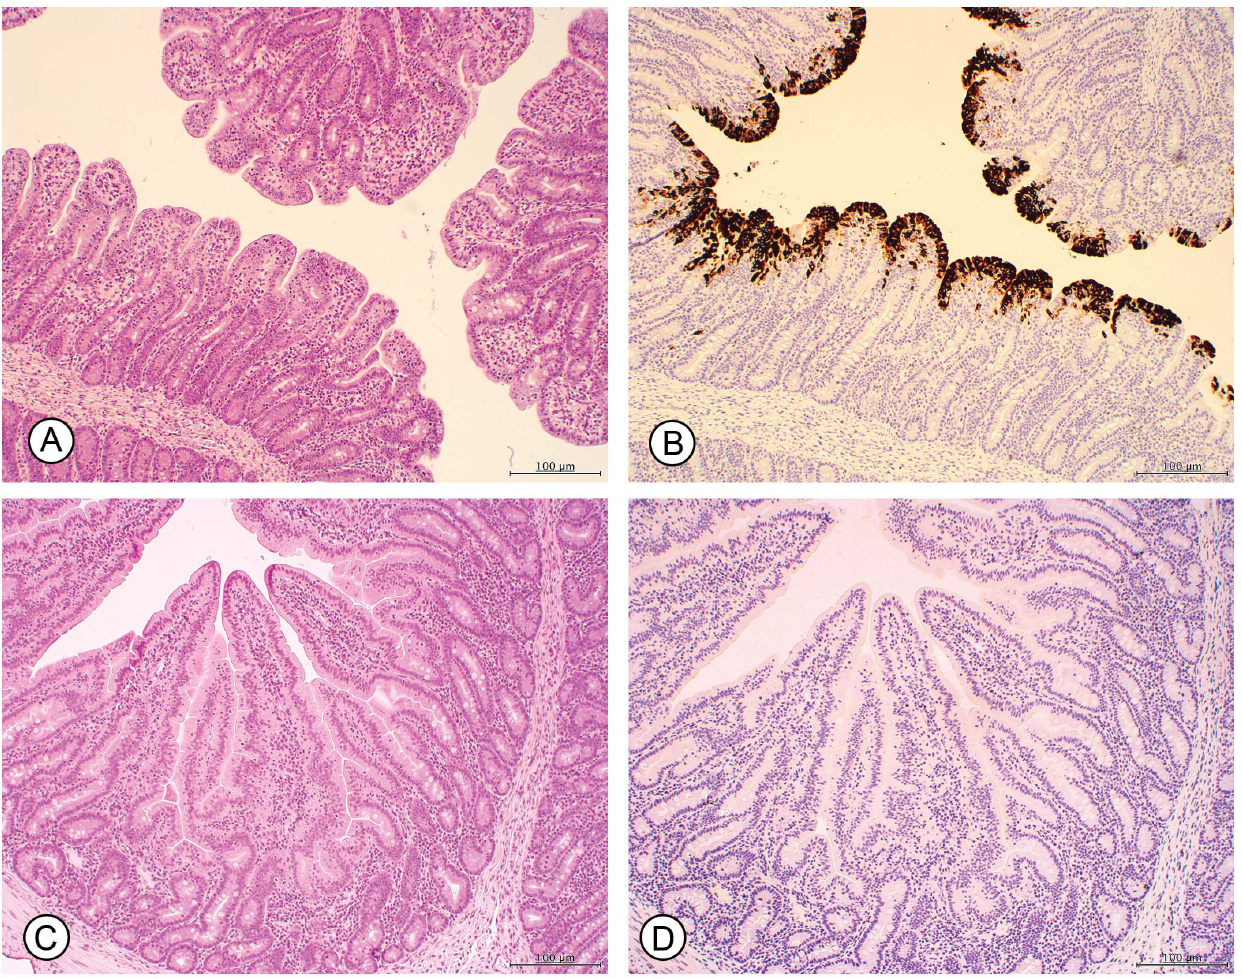
Figure 3. Microscopic lesions in the small intestines at 3 days post PEDV inoculation. ( A ) PEDV-CONTROL. HE. There is severe diffuse atrophy and fusion of villi of the small intestine. ( B ) PEDV-CONTROL. PEDV IHC. The majority of the enterocytes contain abundant PEDV antigen as indicated by brown staining of enterocytes. ( C ) SDPP-CONTROL. HE. The intestinal mucosa is normal and the villi are of normal length. ( D ) SDPP- CONTROL. PEDV IHC. PEDV antigen is not